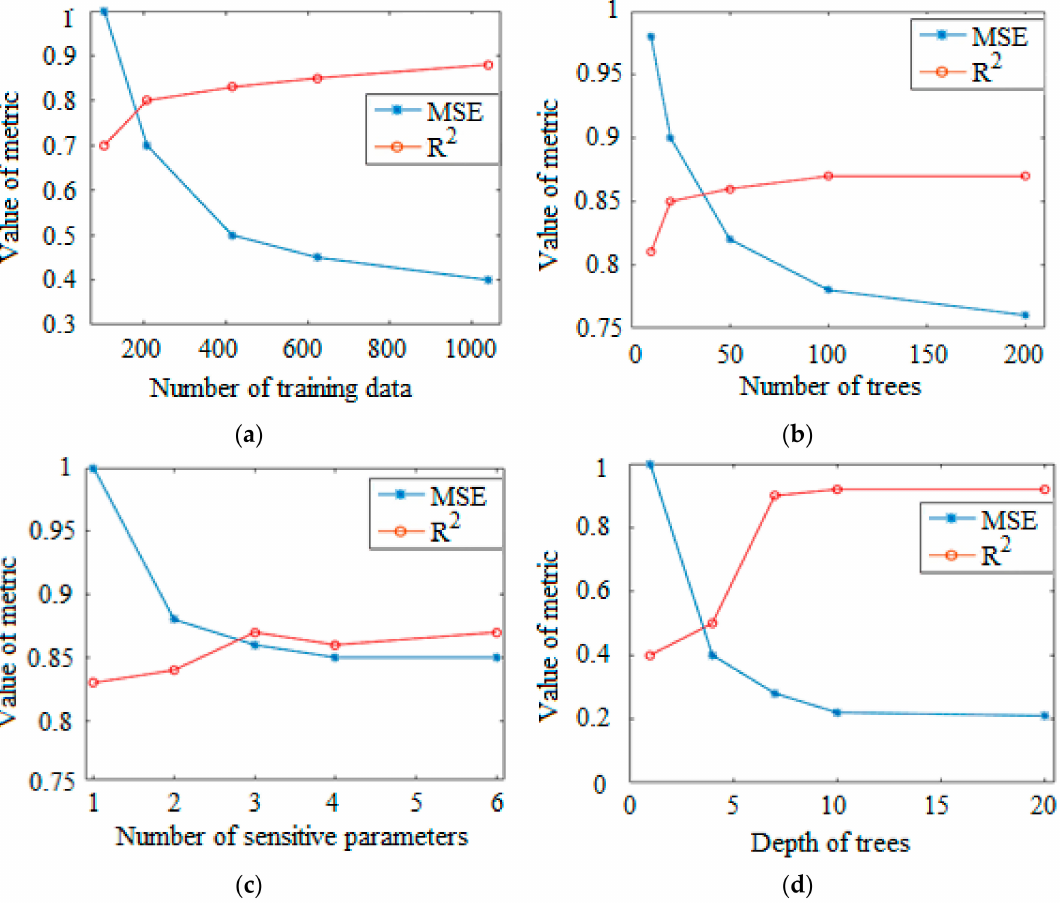
Figure 12. Variations in predicted base pressure ( β ) for different variables of the RF model: Metric value versus ( a ) ( ´ n data ) , (cid:16) (cid:17) ´ n dep ( b ) ( ´ n tree ) , ( c ) ( ´ n var ) , and ( d )